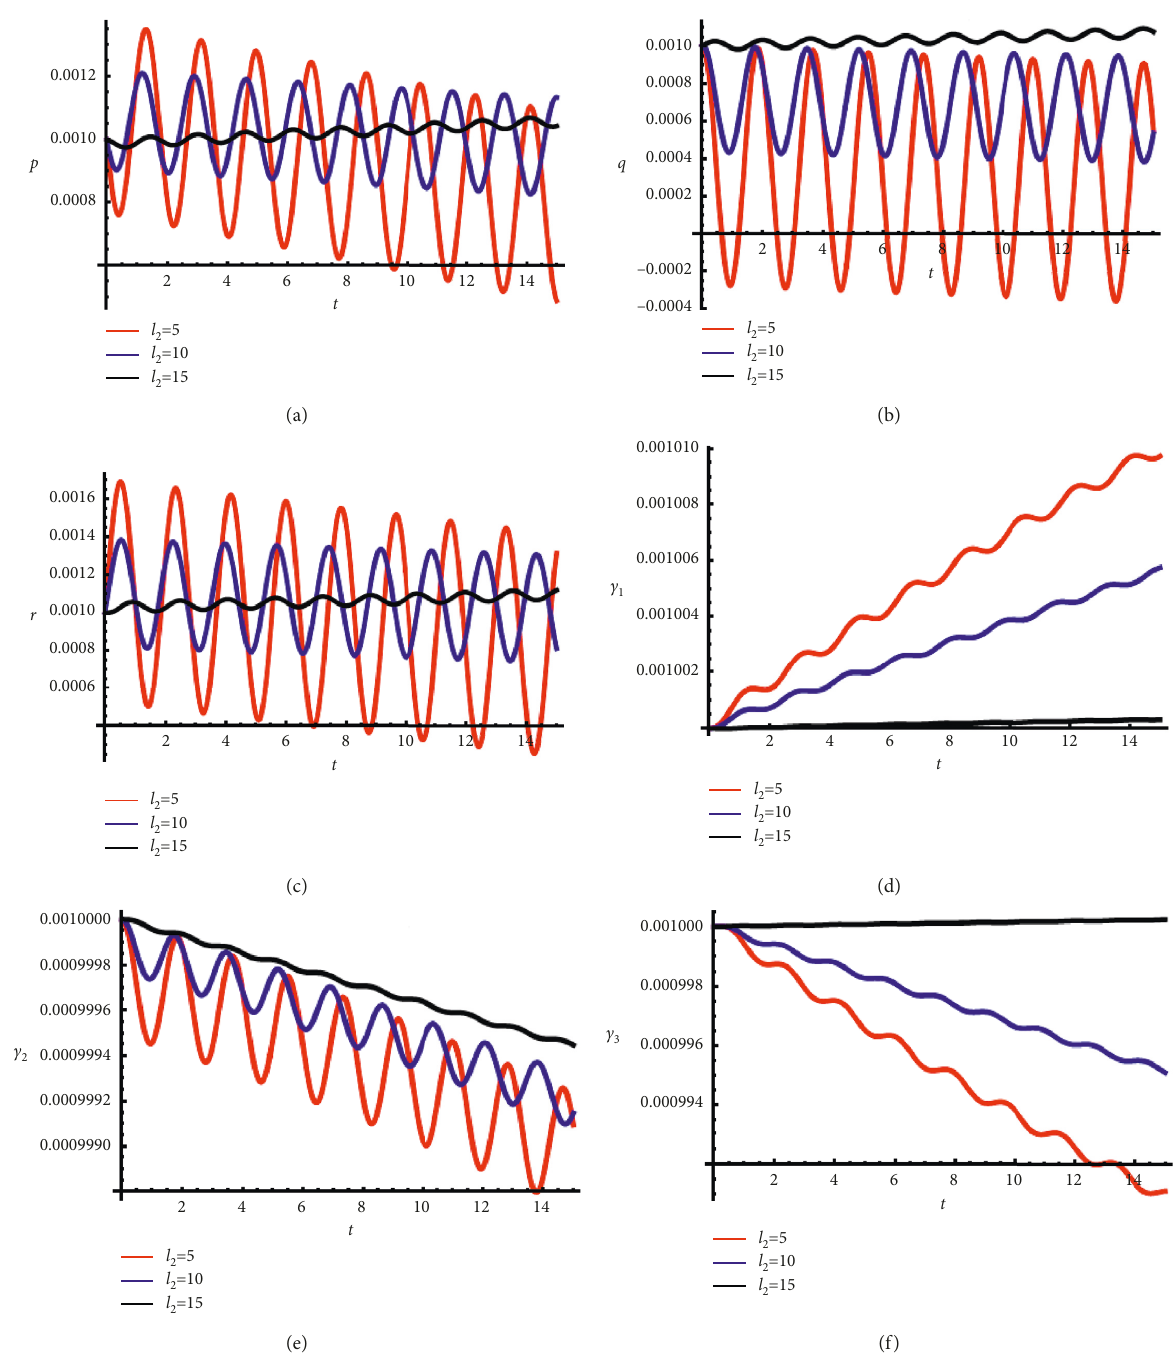
Figure 3: Time histories of the numerical solutions of p,q,r, c